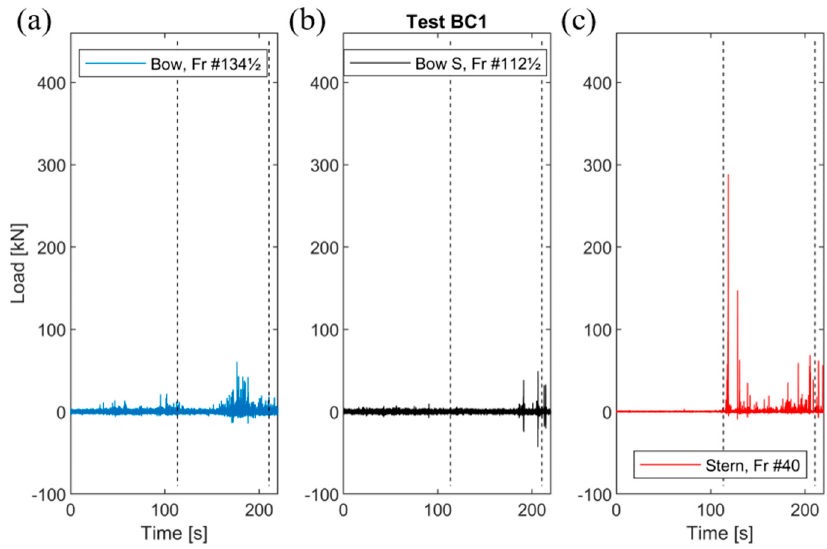
Figure A5. Measured ice-induced loads at ( a ) bow, ( b ) bow shoulder, and ( c ) stern shoulder during test BC1.